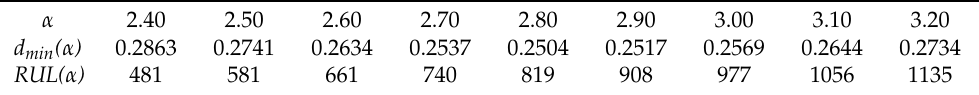
Table 5. Similarity evaluation for RUL estimation of Beaing1-7 using